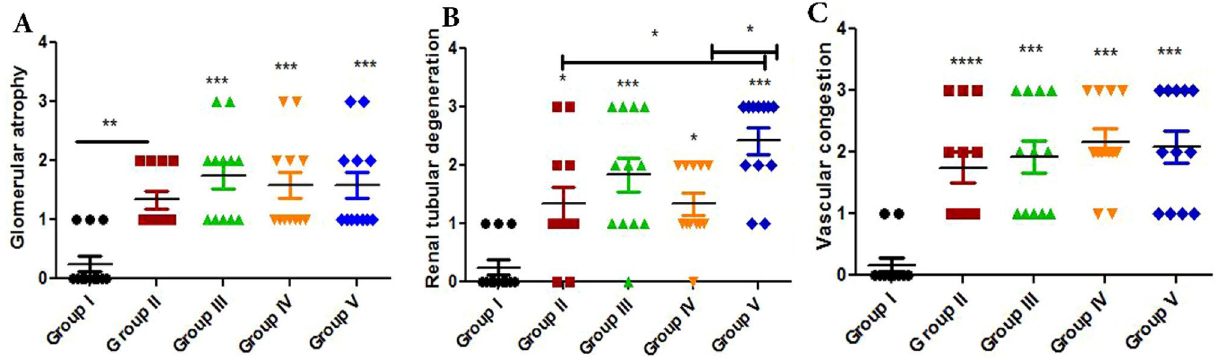
Figure 7. Histomorphometry graph showing the semiquantitaive measurements of rats kidney alterations between the experimental groups. Plots showing ( A ) glomerular atrophy, ( B ) renal tubular degeneration and ( C ) vascular congestion among the experimental groups. Data were represented as mean ± standard error. Significant differences versus the control groups determined through one-way ANOVA with Tukey’s post hoc test are marked by different asterisks: *P ≤ 0.05, **P ≤ 0.01, ***P ≤